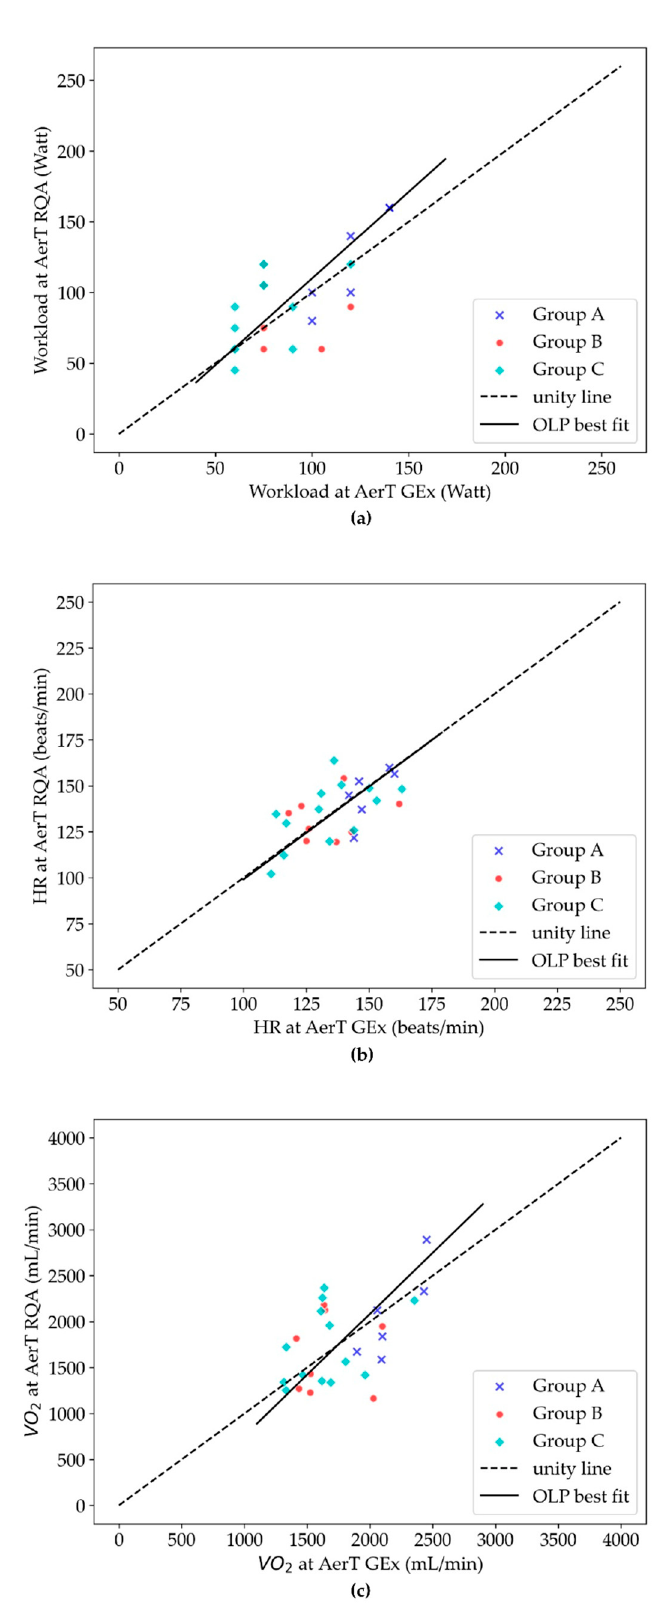
Figure 3. OLP regression line on ( a ) Workload y = 1.24 × − 12.55; ( b ) HR y = 1.01 × − 1.92; ( c ) VO 2 y = 1.33 × − 570.18 at AerT all values correspond to the mimima DET min. Group A (blue stars), B (red circles), and C (light blue diamonds).